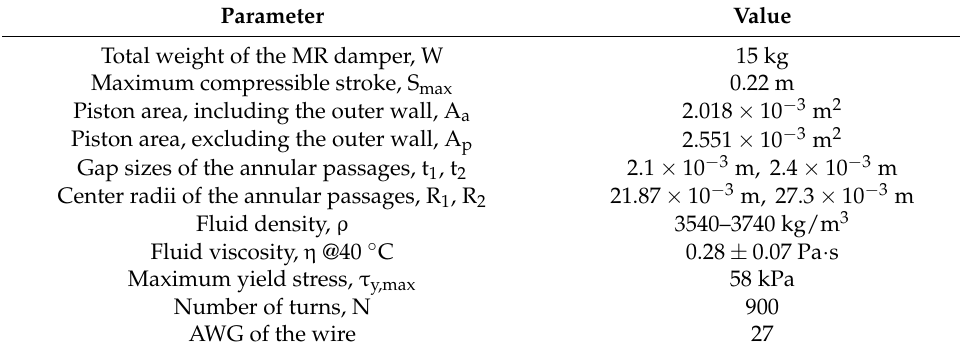
Table 1. Parameters of the MR damper landing